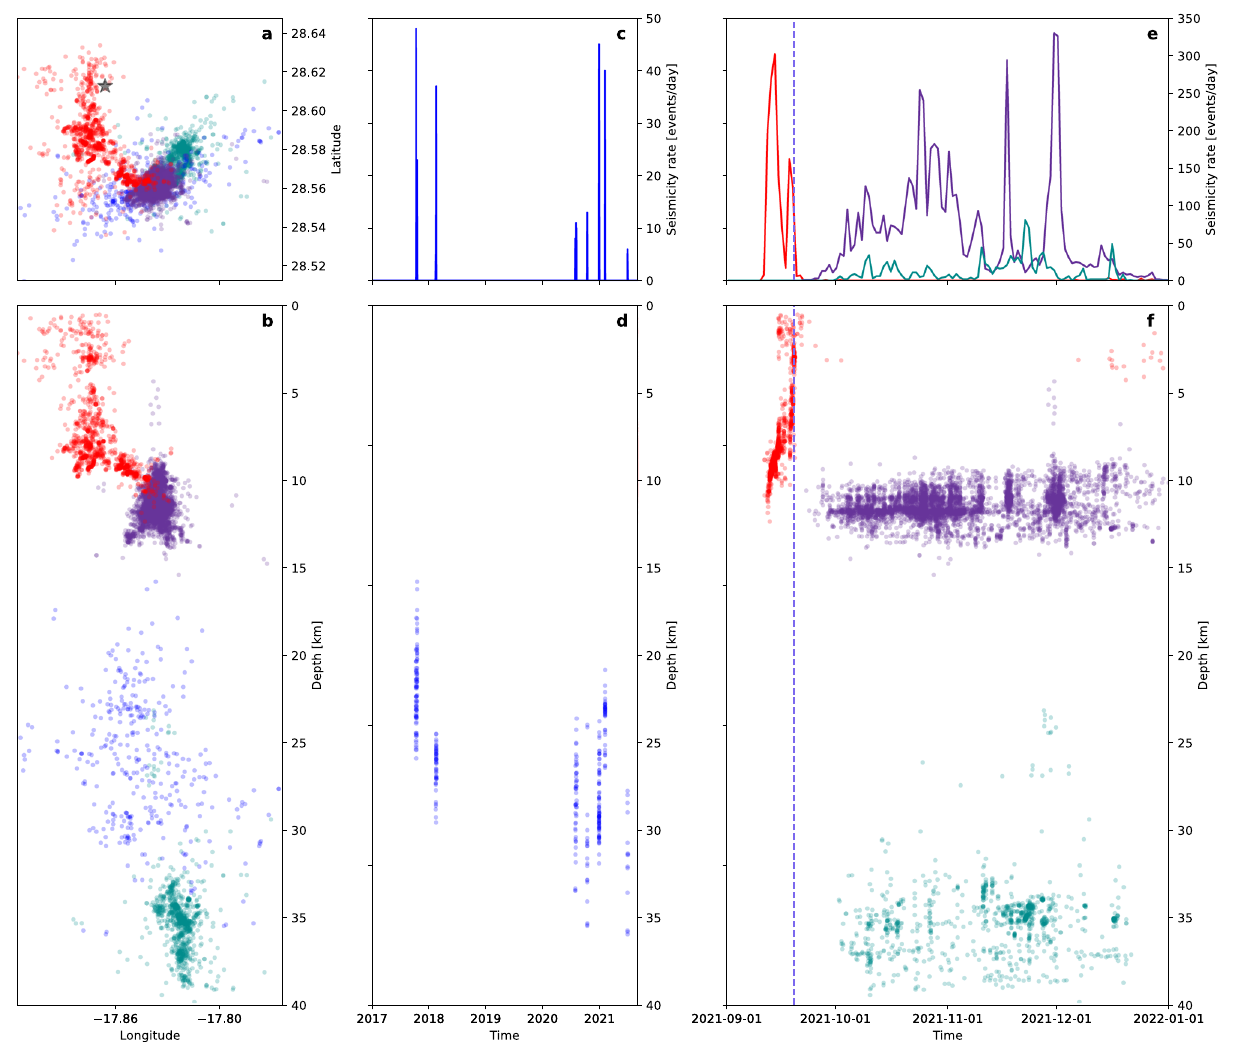
Fig. 2 | Spatiotemporal evolution of seismicity at La Palma. a, b Relocated seismicityandlocationofthe fi rstvent(blackstar)inmapview( a )andverticallyby longitude,wheretheaspectratioisconserved( b ). c Seismicityrateduringthe2017- 2021swarmperiod. d Depthof2017-2021swarmeventsovertime. e Seismicityrate duringSeptember-December2021,includingdikeintrusion,eruptive(adashedline